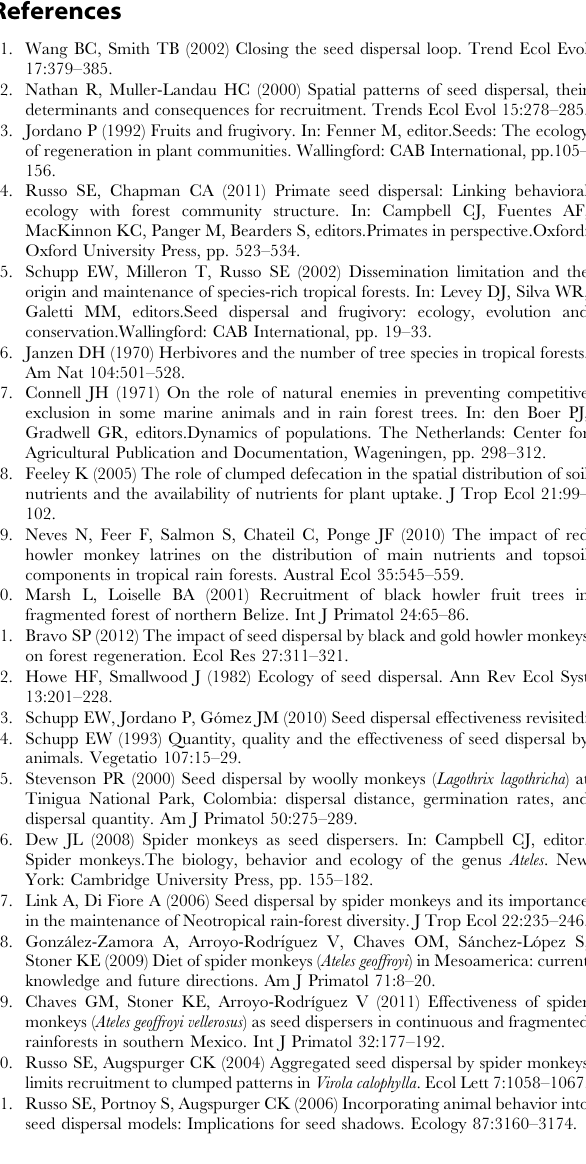
Table S1 Availability of top food tree species in continuous forest sites and fragmented forests in the Lacandona region, Mexico. The total number of trees and total basal area (m 2 , in parentheses) is indicated for each tree species. Table S2 Seed species deposited by spider monkeys during a 13-mo period in 60 latrines located in two continuous forest sites and three forest fragments in the Lacandona region, Mexico. The total number of seeds (and percentages, in parentheses) is indicated for each forest condition and for the entire landscape (i.e., considering both forest